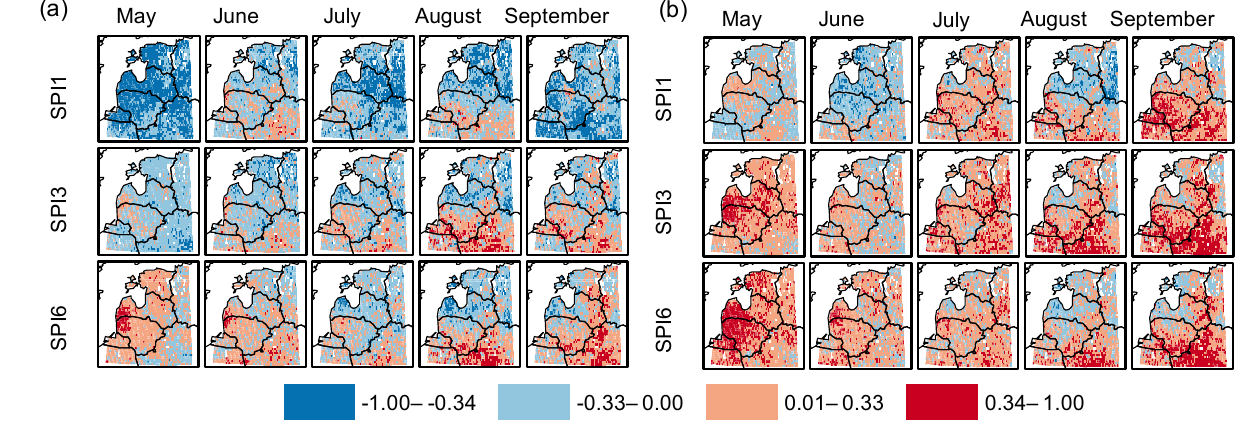
Figure 7. The Pearson correlation coefficient between VCI and SPI values of the same month (a) and between VCI and SPI with 1-month lead (b) . Coefficients larger than 0.34 and smaller than − 0.34 are statistically significant at